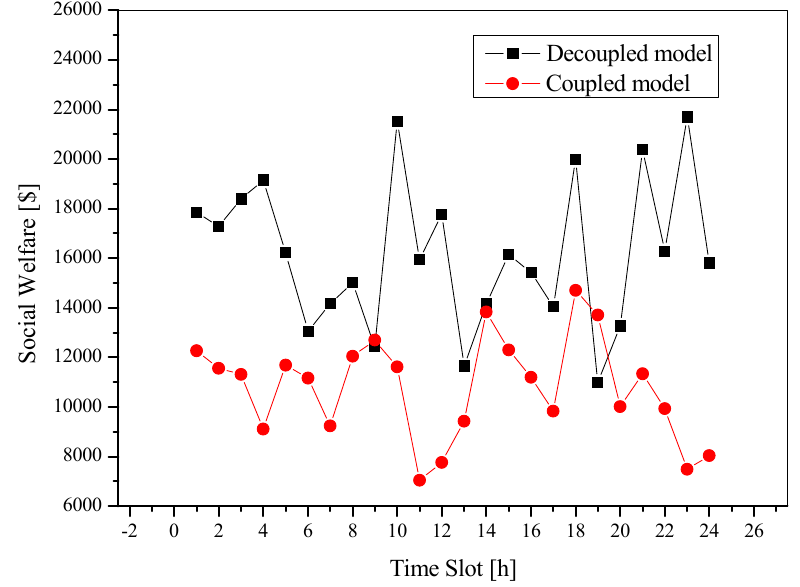
Figure 7. Comparison of the social welfare of two cases.